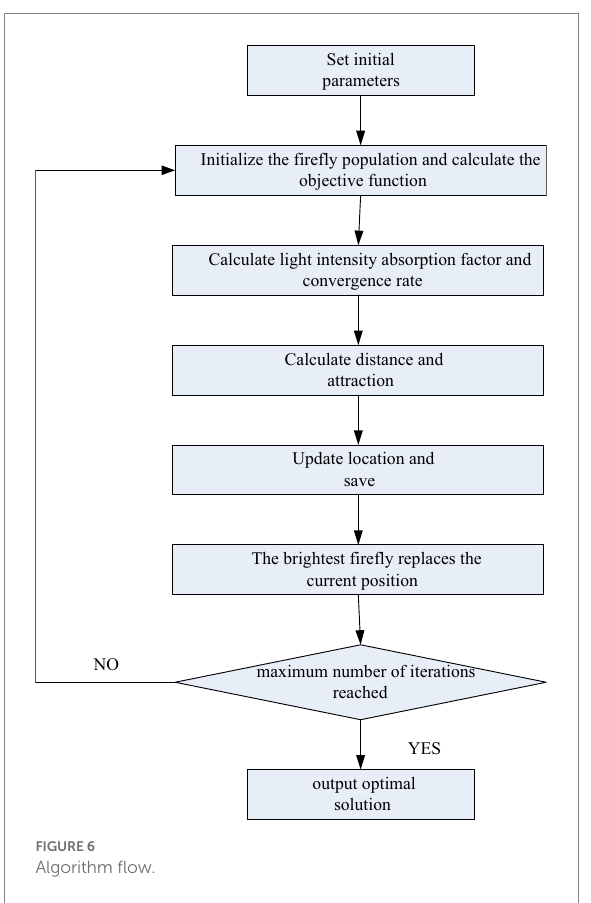
FIGURE 6 Algorithm